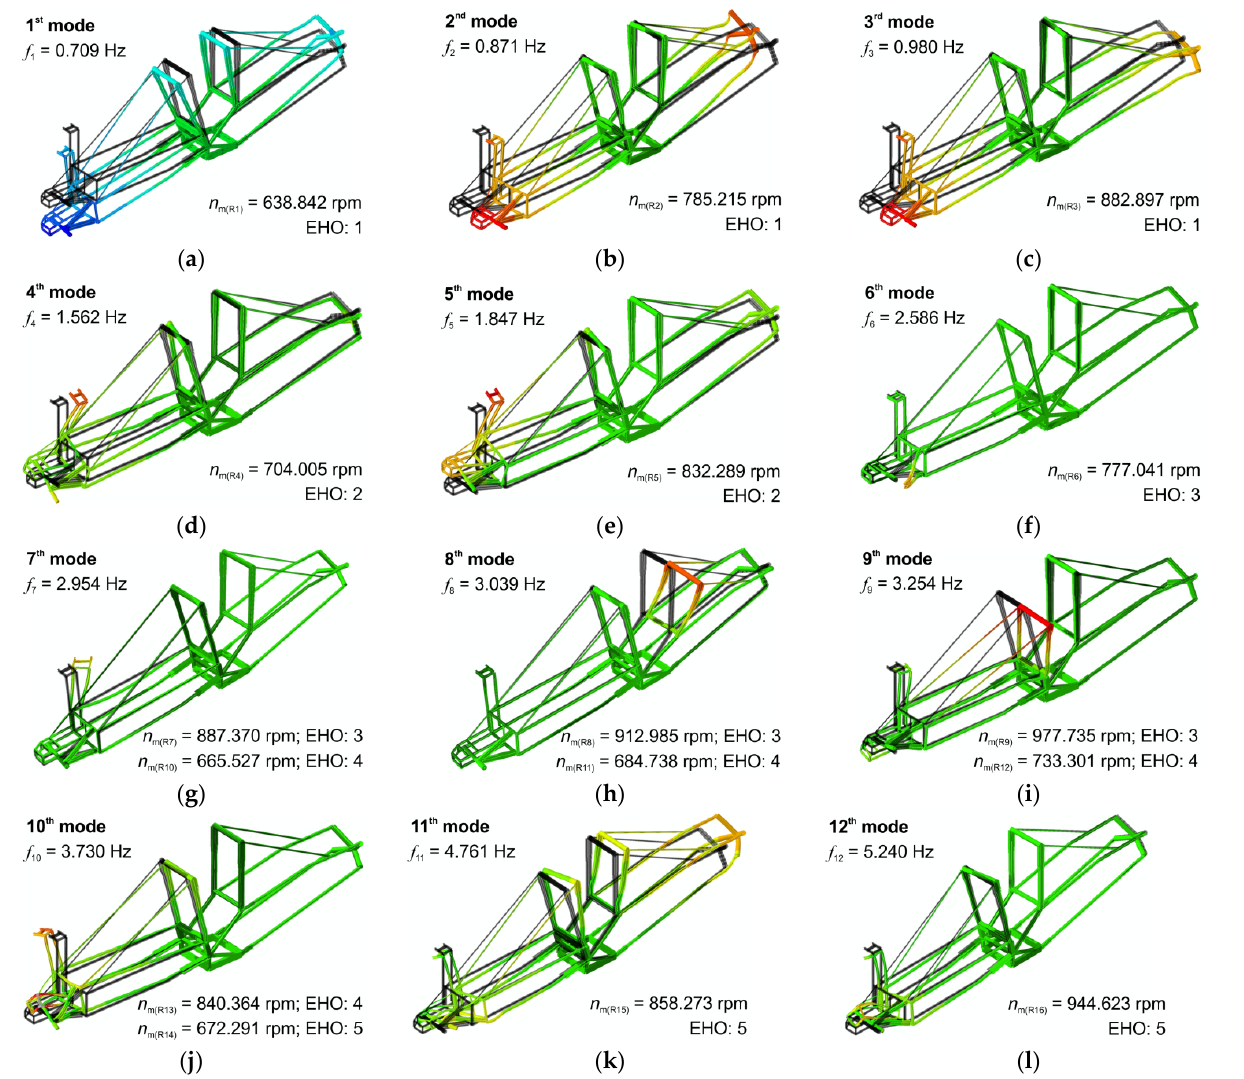
Figure 19. The first 12 modal shapes ( a – l ) of the slewing superstructure: natural frequencies ( f i , i = 1, 2, …, 12), resonant FREMs ( n m(Rj) , j = 1, 2, …, 16) and the EHOs.